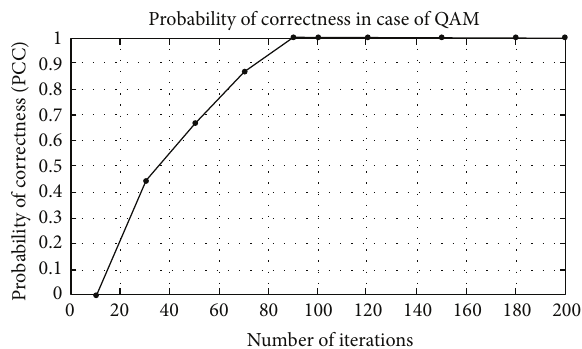
Figure 14: Probability of correctness (PCC) versus number of iterations at SNR = 10 dB for QAM32 example.